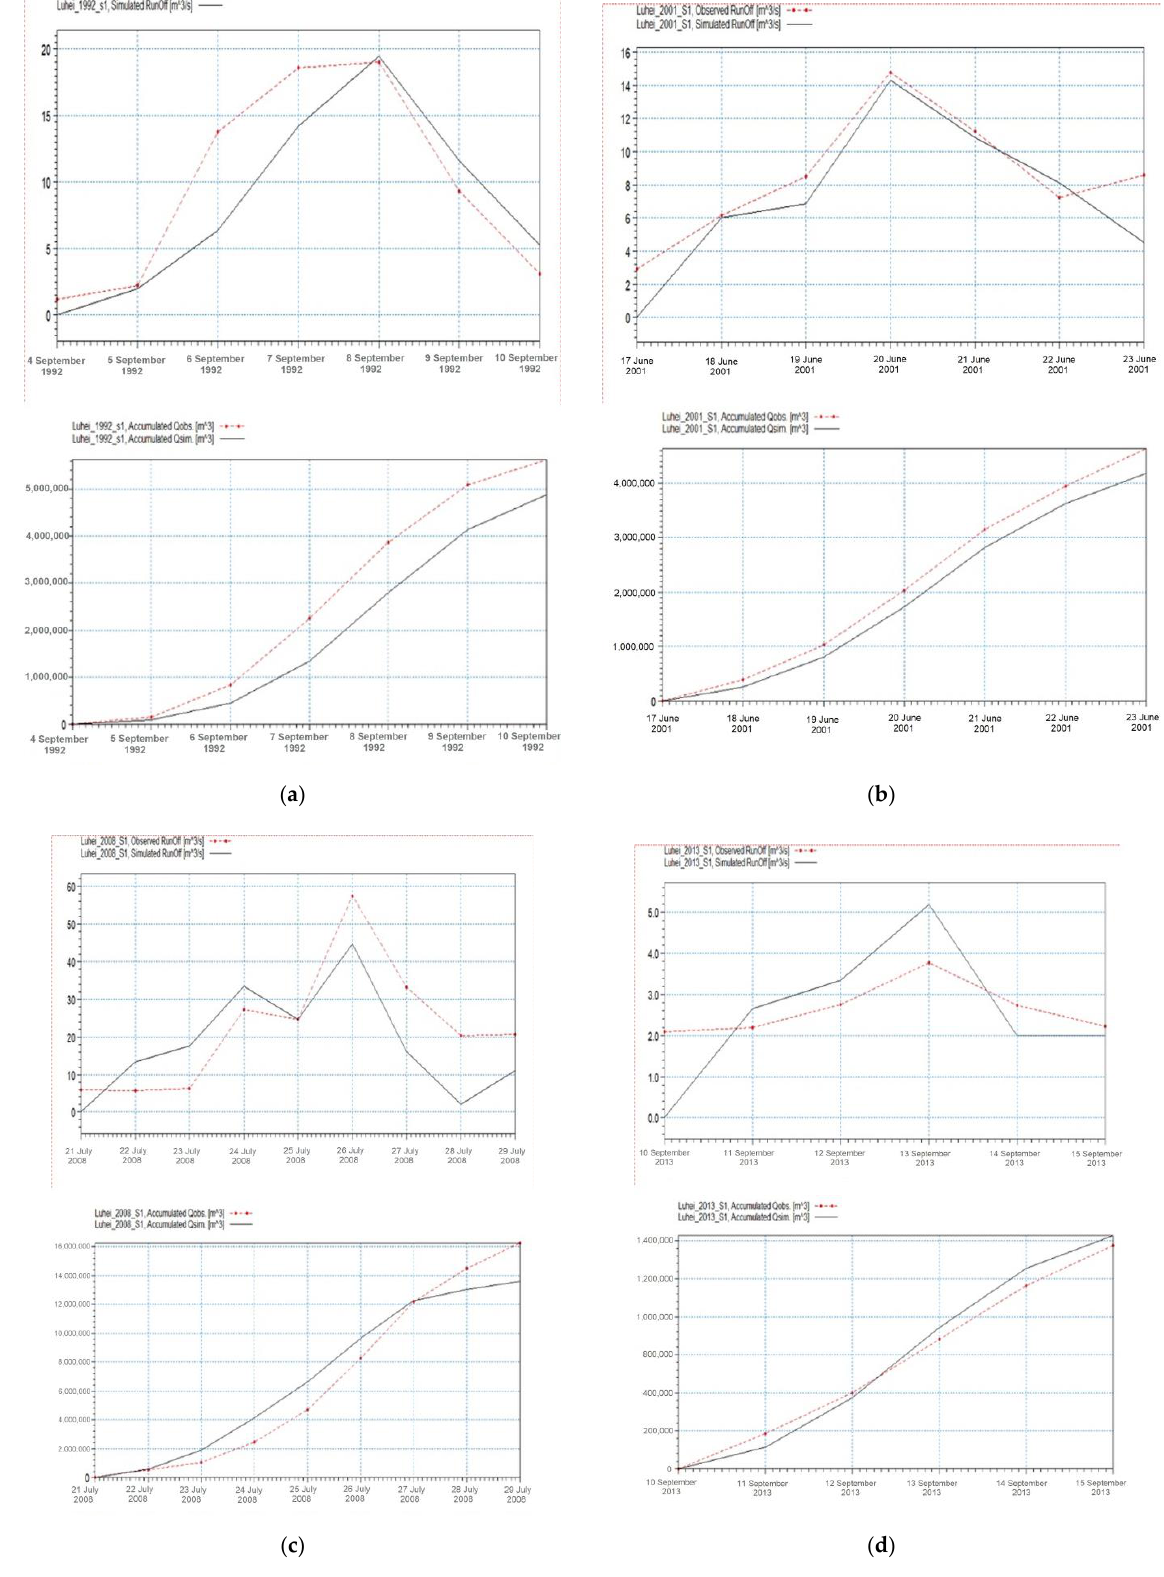
Figure 14. Simulated and observed instantaneous unit hydrograph results. ( a ) Runoff and Q acumulated—1992; ( b ) Runoff and Q acumulated—2001; ( c ) Runoff and Q acumulated—2008; ( d ) Runoff and Q